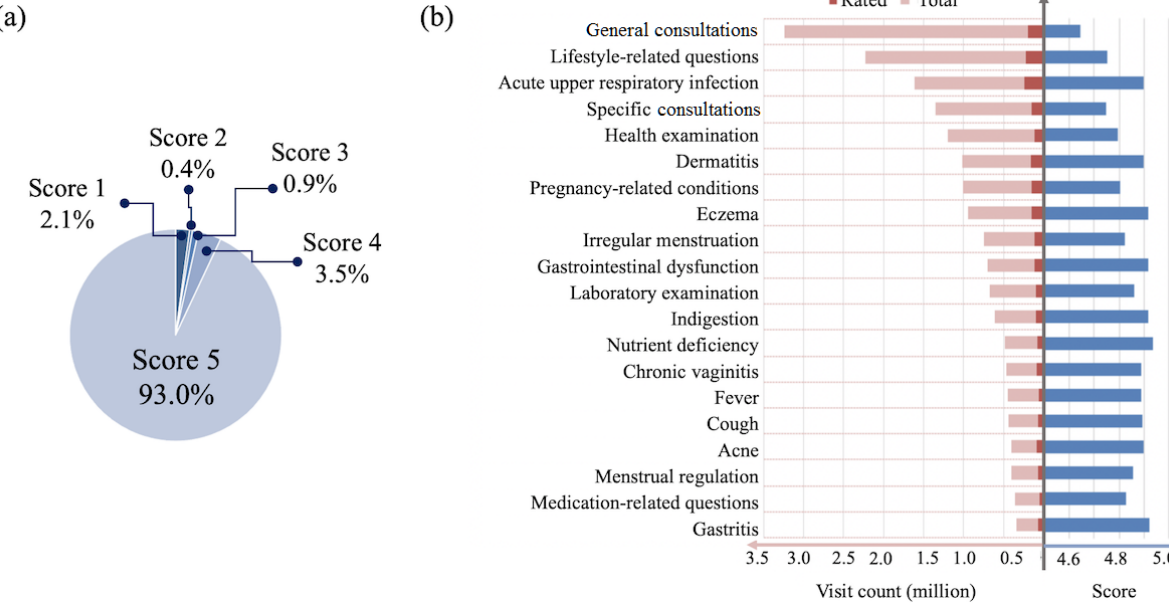
Figure 8. Users’ satisfaction with the online consultations: (a) the distribution of satisfaction scores; (b) the proportion of users who scored the consultations and inquisitions and the corresponding scores related to the top 20 diseases. Scores range from 1 (least satisfaction) to 5 (most